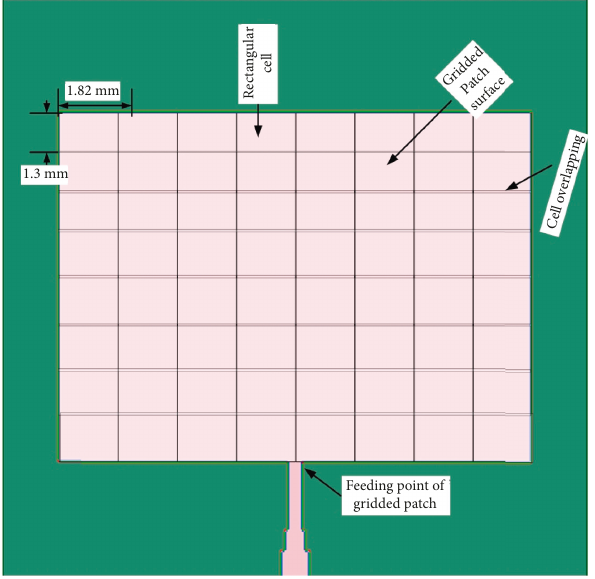
Figure 3: Division of patch surface for binary-coded genetic